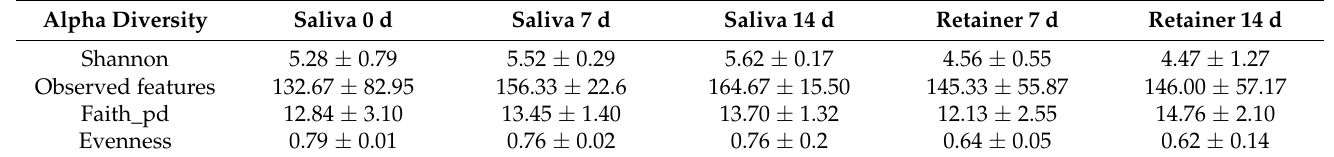
Table 1. Alpha diversity comparisons between saliva and retainer at 7 and 14 days.